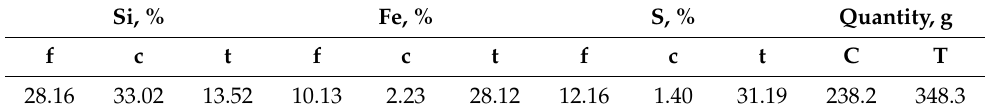
Table 6. Concentrate (C) and tail (T) in grams obtained after flotation process and Si %, Fe %, and S % grades in the feed (f), concentrate (c), and tail (t) obtained by FRX.